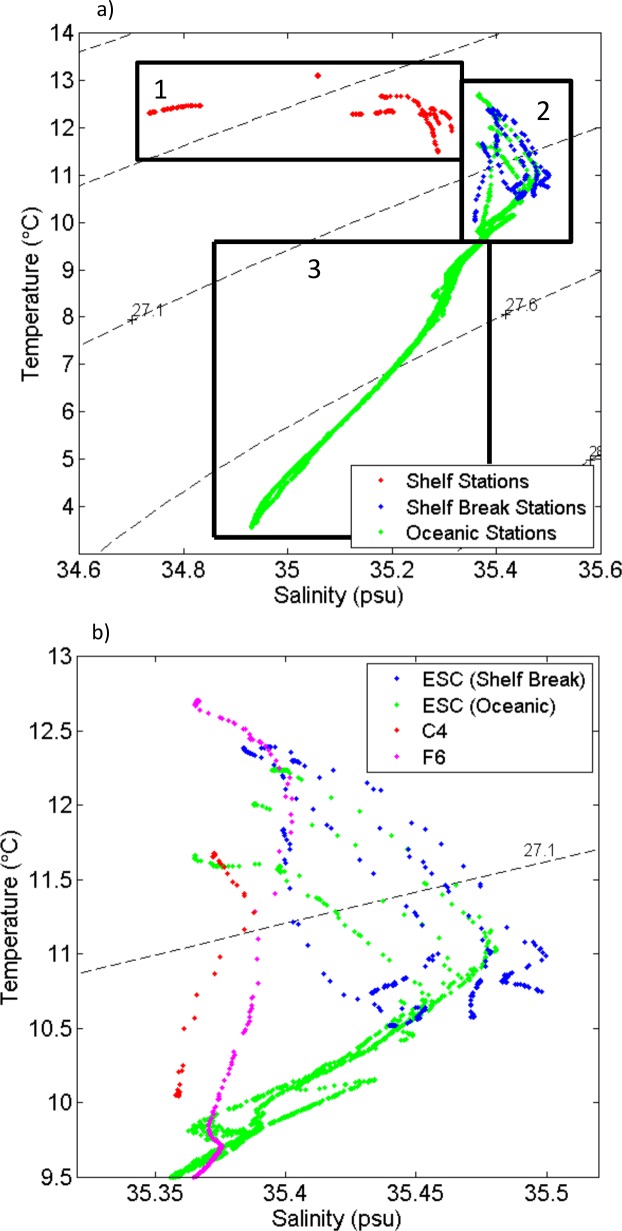
Water temperature and salinity diagram with isopycnals (dashed lines) of a) all stations. Box 1 shelf water, box 2 surface water for shelf break and oceanic stations, box 3 water below 200 m at oceanic stations. b) detailed view of box 2 with stations with an ESC signature marked in blue (shelf break stations) and green (oceanic stations) and stations outside the ESC in red (C4) and magenta (F6).